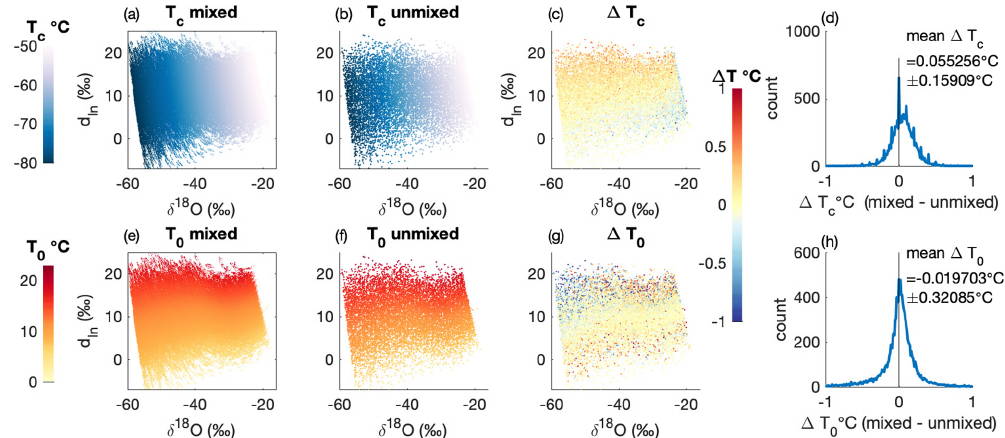
Figure A26. The influence of air parcel mixing on modeled isotope state spaces. ( a, e ) The water-isotope ratios of precipitation resulting from 7 . 5 × 10 5 stochastically mixed distillation pathways, colored by T c and T 0 , respectively. ( b, f ) The water-isotope ratios of precipitation resulting from the corresponding 1 . 5 × 10 4 unmixed distillation pathways, colored by T c and T 0 , respectively. ( c, g ) The difference in T c and T 0 , respectively, between the mixed and unmixed pathways as a function of the δ 18 O and d ln space. ( d, h ) Histograms of the differences, (cid:49)T c and (cid:49)T 0 , from all points in the δ 18 O and d ln space, resulting from mixing.